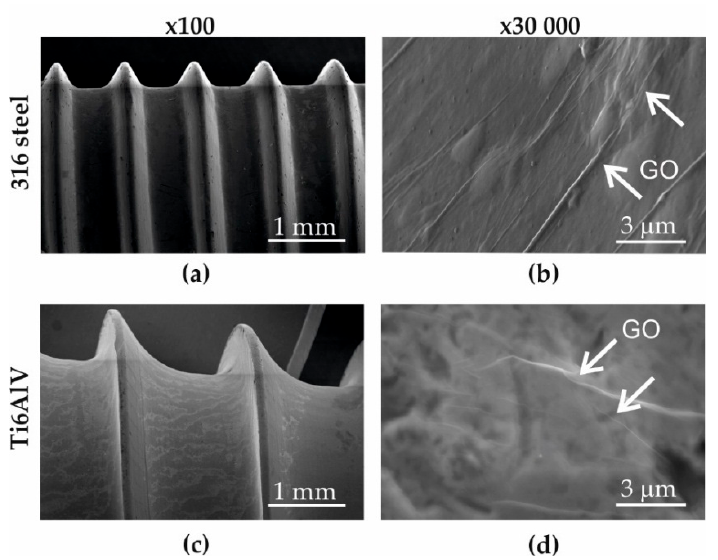
Figure 3. SEM image of the screw surface: ( a , b ) stainless steel 316 and ( c , d ) alloy Ti6Al4V (the arrows point the GO layers).